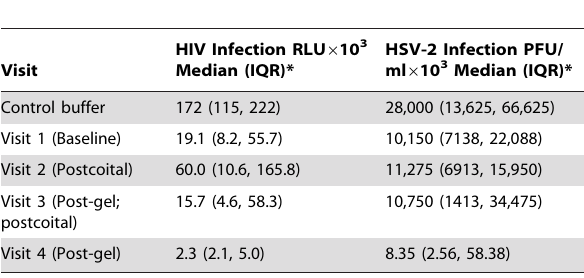
Table 2. Viral infection in presence of each CVL or control buffer.